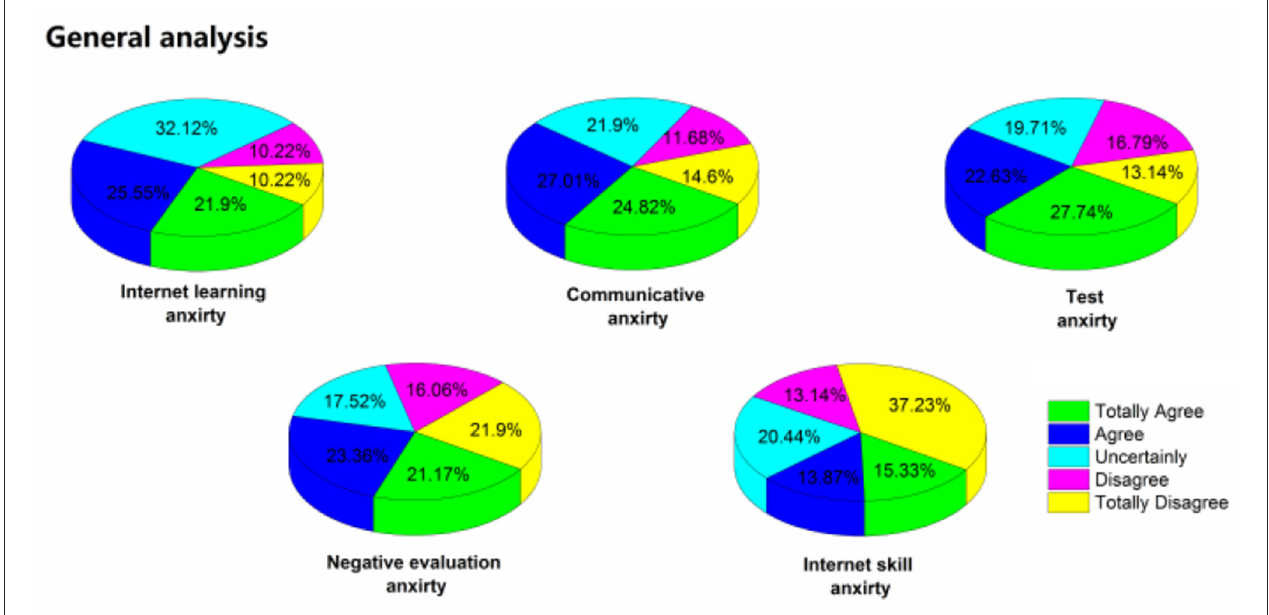
FIGURE 1 | Proportion of different types of anxiety.